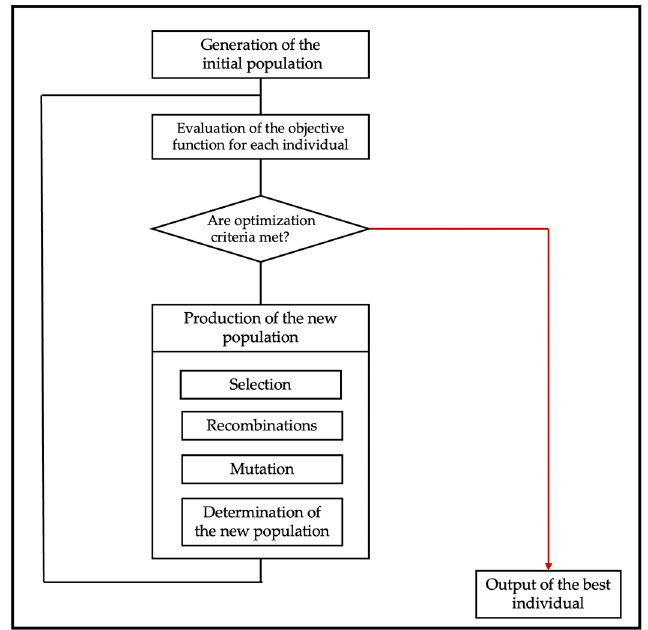
Figure 4. Structure of a simple genetic algorithm.